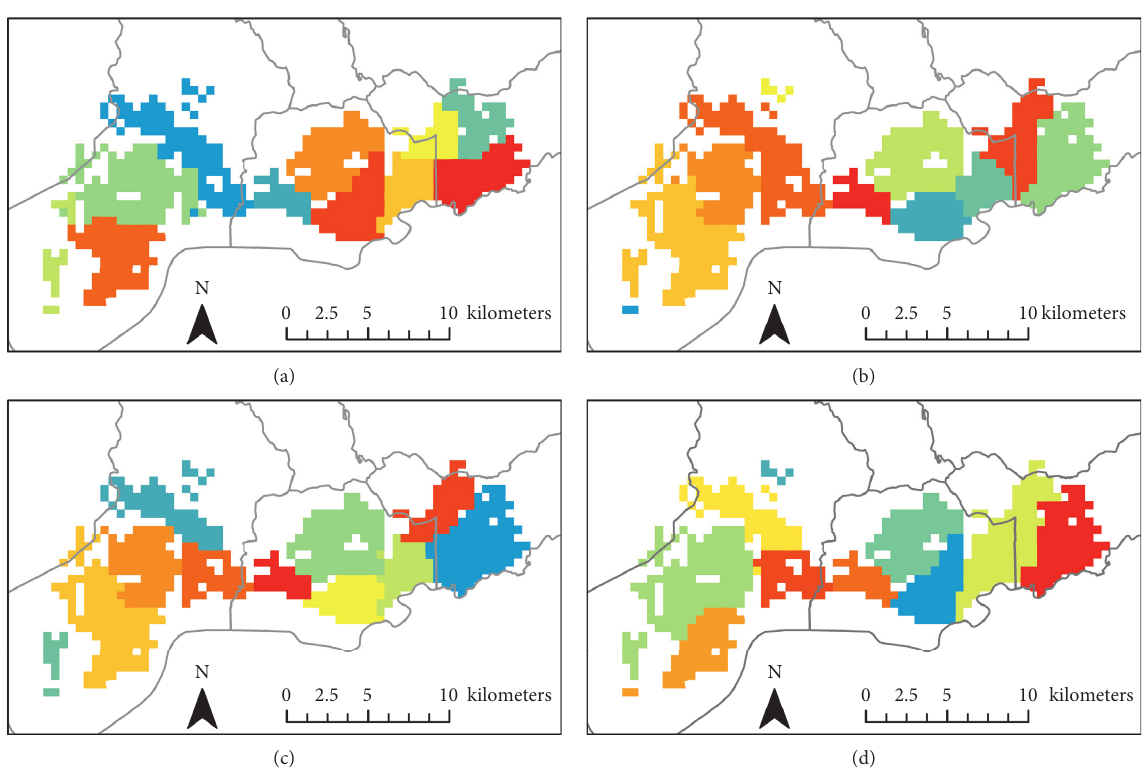
Figure 5: Spatial distribution of community detection in four periods. (a) Community detection in 07:00–10:00. (b) Community